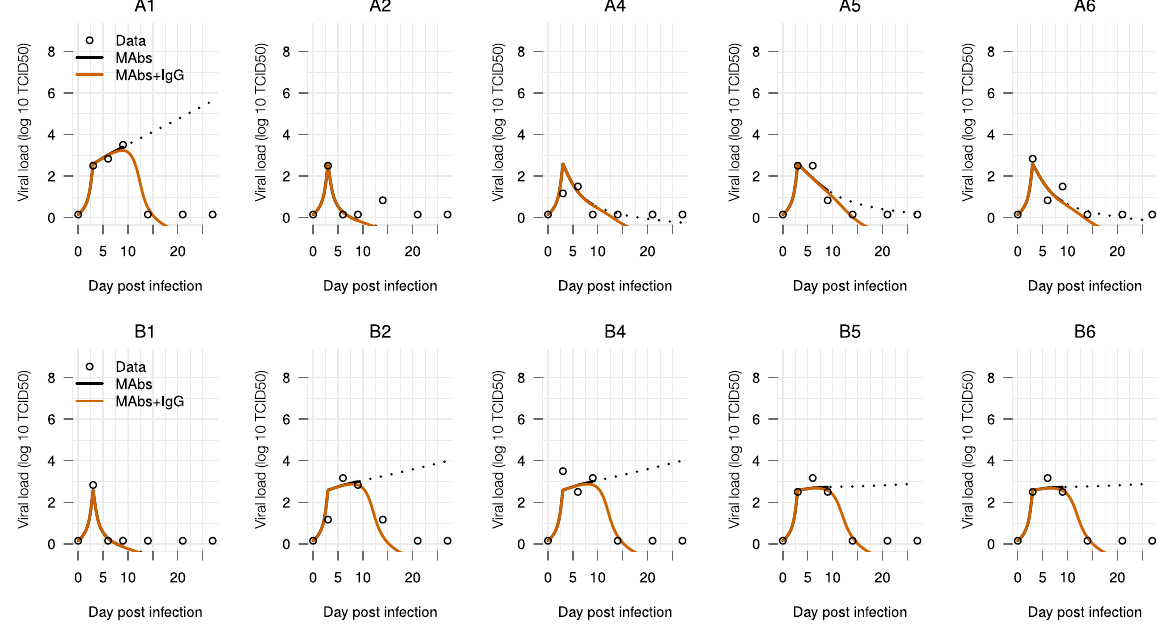
Figure 5. Fitting the mAbs treatment effect model. mAbs : fitted model with only mAbs effect during the first nine dpi, dashed lines show the extrapolated viral load kinetics from this model; mAbs - IgG : adding the general IgG profile with the working threshold K Ab = 10 4.5 . mAbs half-life is 28 days. Two different combinations of monoclonal antibodies were tested in NHPs (ZMapp1 and ZMapp2) 10 . The top panel of figures ( A1 – A6 ) presents the six NHPs receiving three doses of ZMapp1, while the bottom panel of figures ( B1 – B6 ) presents the six NHPs receiving three doses of ZMapp2 10 .